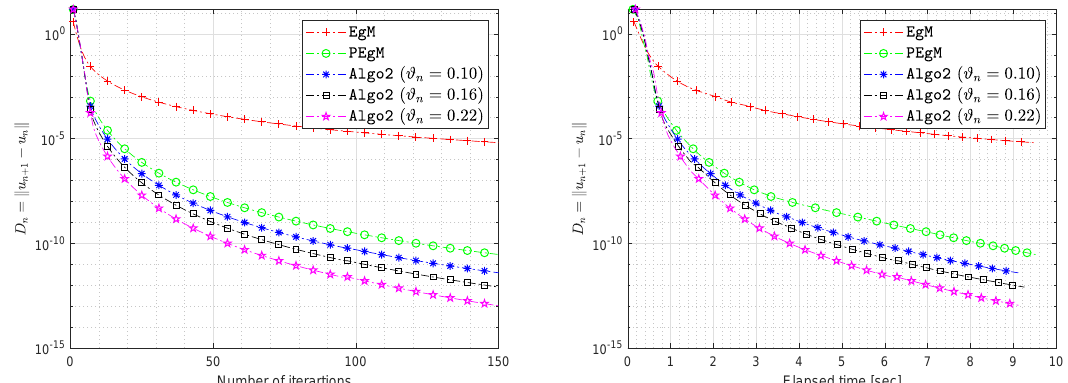
Figure 8. Experiment in Section 6.3.2: Comparison of Algorithm 2 with Algorithm 1 ( EgM ) in [23] and Algorithm 3.1 ( PEgM ) in